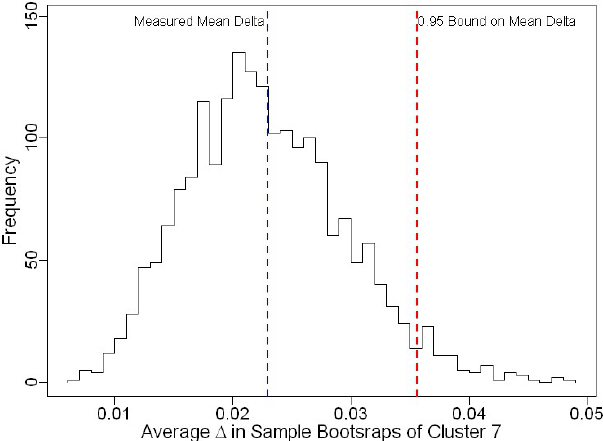
Figure 2. Bootstrap distribution of average delta for a sample cluster—#test cases = 588 and #misses =